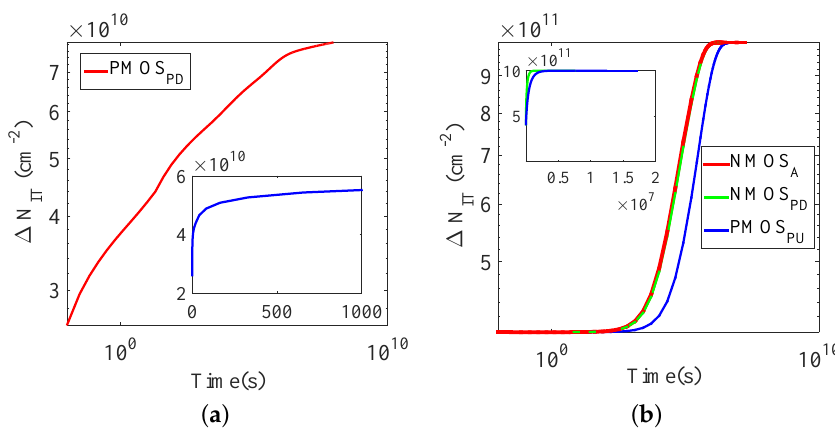
Figure 6. Change in trap charge carrier concentration due to NBTI and PBTI in 6T Static Random-Access Memory (SRAM) cell transistor in standby mode of operation: ( a ) using two stage NBTI model and ( b )